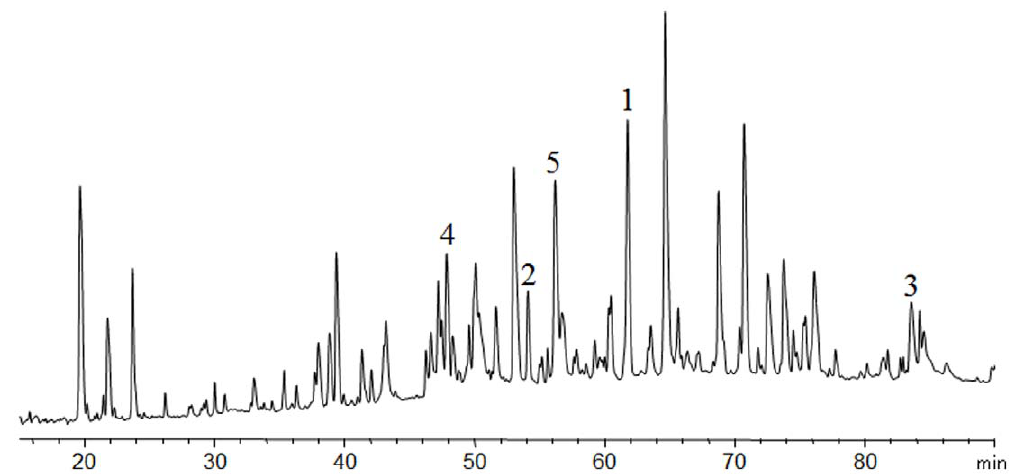
Figure 4. Five peptides with disulfide linkages identified by disulfide mapping.